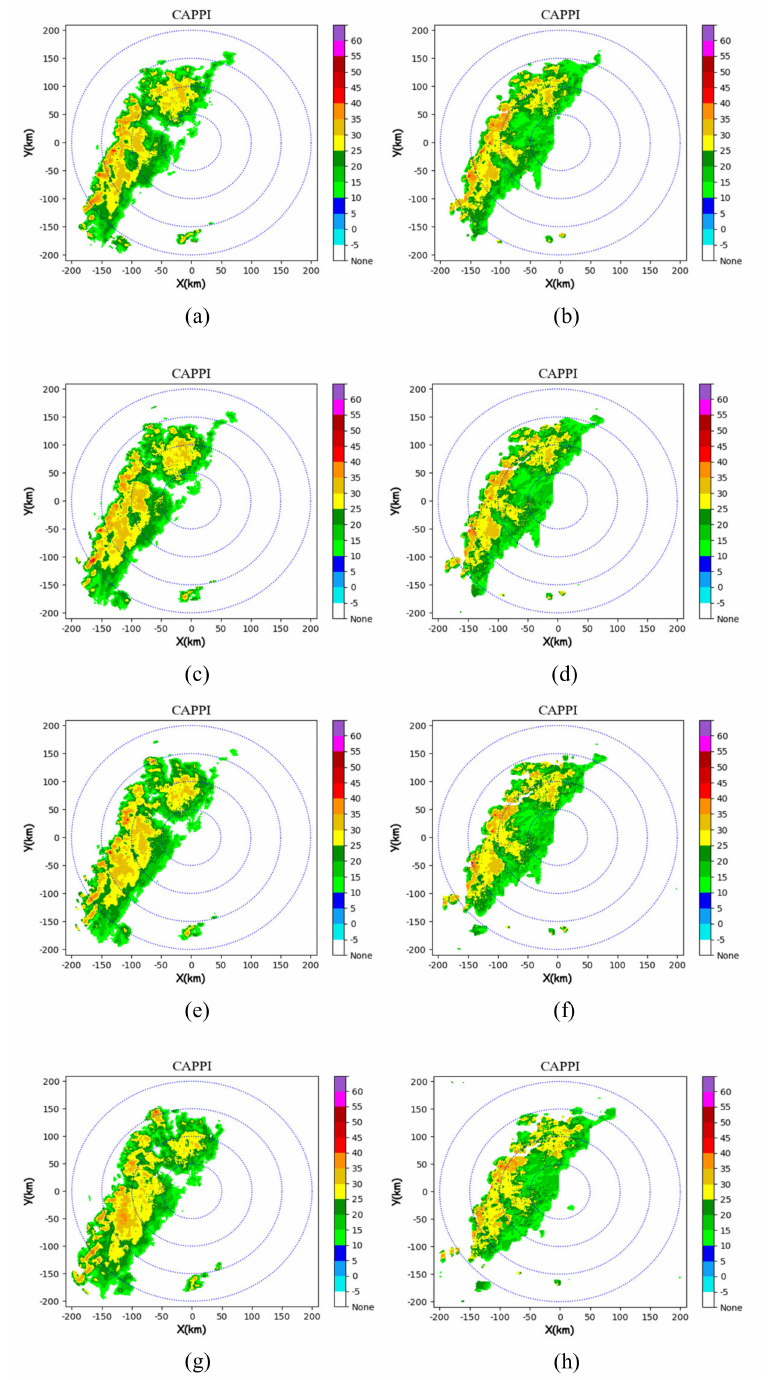
Figure 10. Comparison between the extrapolation results of the CTREC algorithm at 0.5 h and the actual situation (( a ) 00:18 actual situation, ( b ) 00:18 extrapolation, ( c ) 00:30 actual situation, ( d ) 00:30 extrapolation, ( e ) 00:42 reality, ( f ) 00:42 extrapolation, ( g ) 00:60 reality and ( h ) 00:60